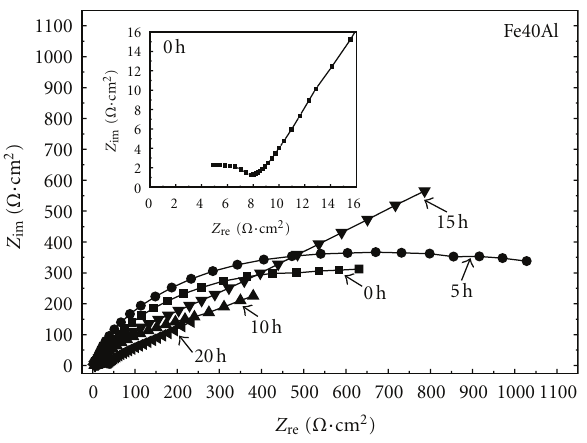
Figure 7: Nyquist diagrams for Fe40Al + 2.5Ag in the KCl + ZnCl 2 mixture at 670 ◦ C.